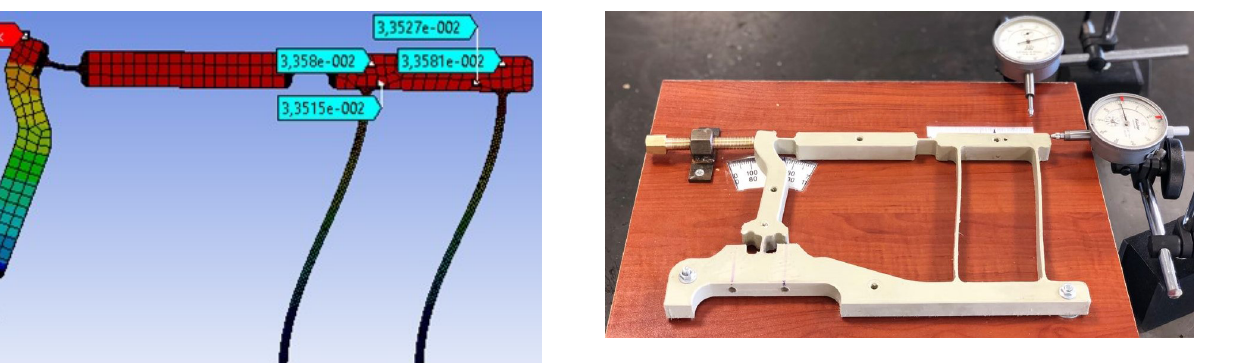
Figure 12. Experimental setup.